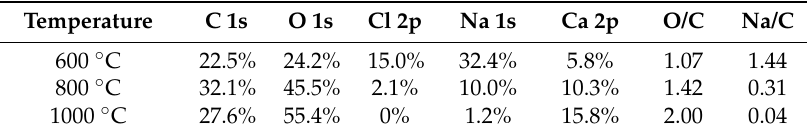
Table 3. Composition and ratios of surface elements of